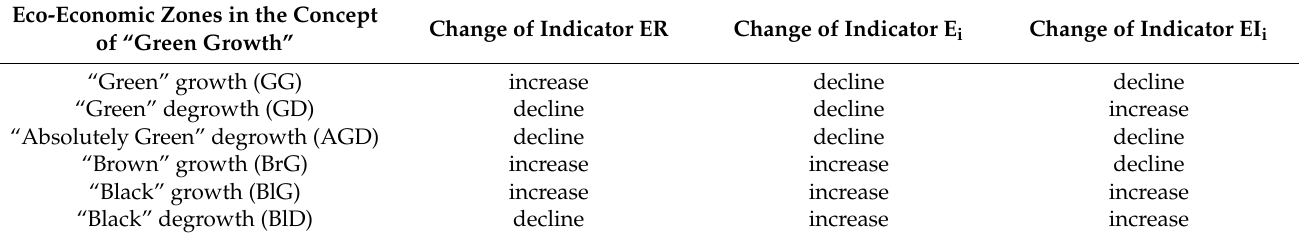
Table 3. Interpretation of ecological and economic zones according to the modified model of P. Victor [2].